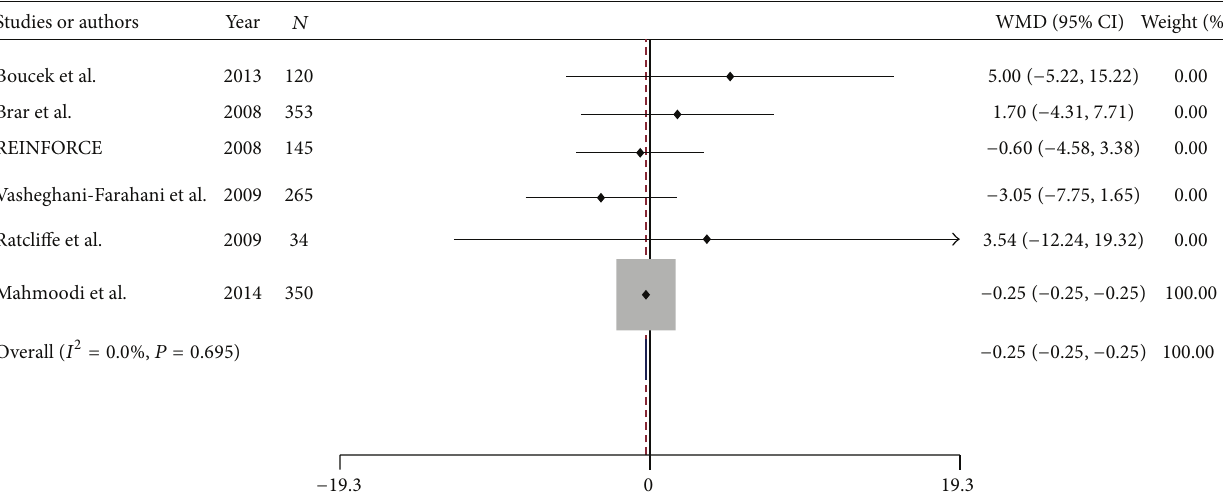
Figure 3: Forest plot of weighted mean differences (WMD) for hydration with sodium bicarbonate on mean changes of creatinine.